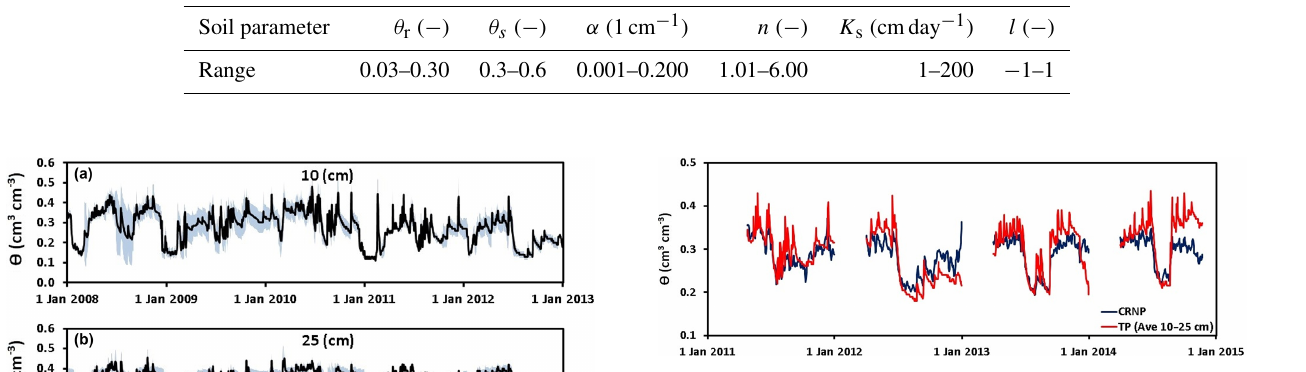
Figure 5. Time series of daily CRNP and spatial average TP SWC ( θ ) data.